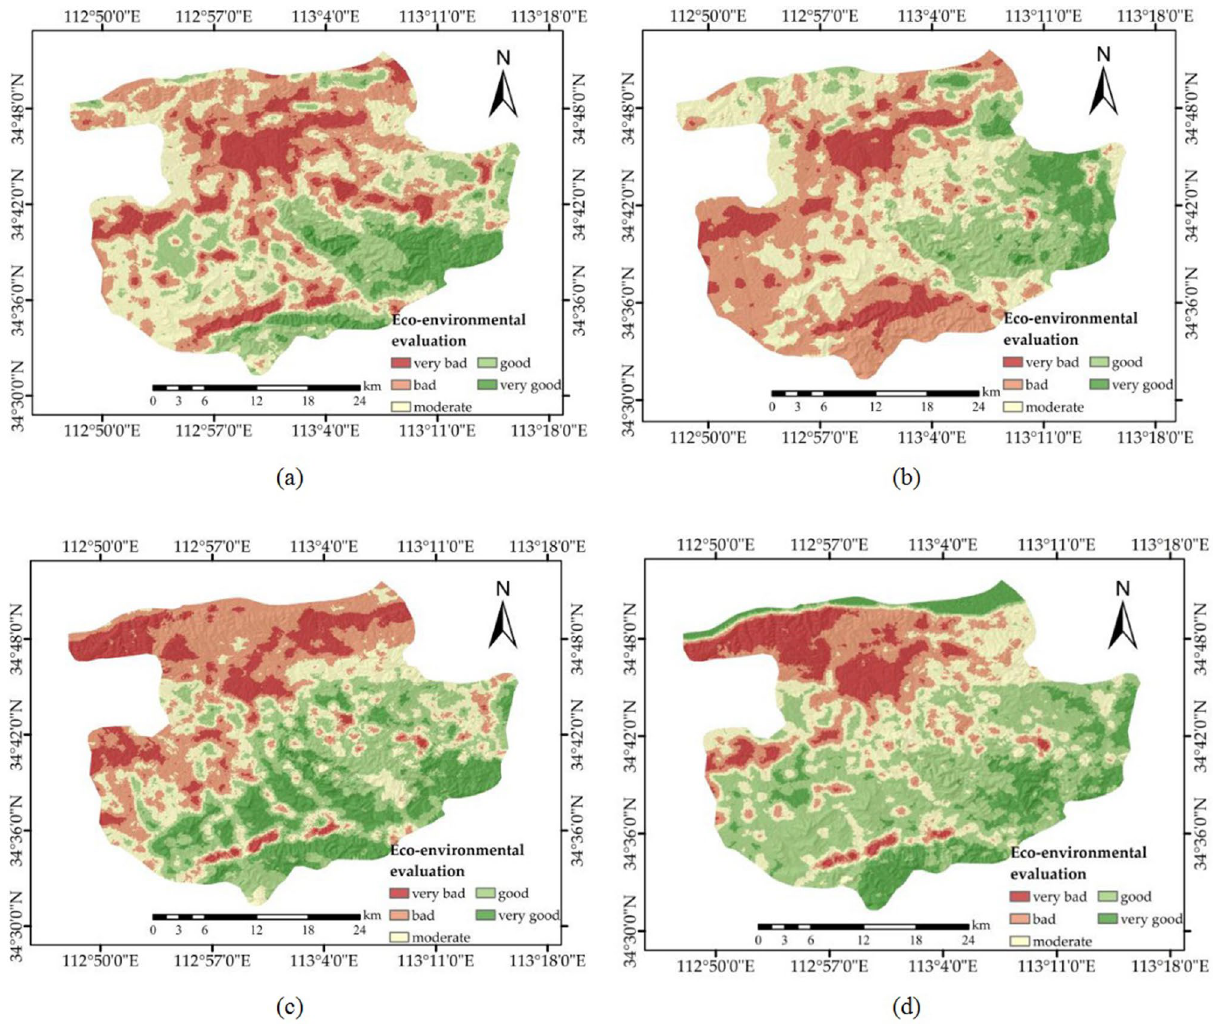
Figure 8. Eco-environment assessment maps of the mining area in Gongyi. ( a ) Maps of spring; ( b ) maps of summer; ( c ) maps of autumn; and ( d ) maps of winter. The Figure is created using ArcGIS ver.10.3 (https:// www. esri. com/).